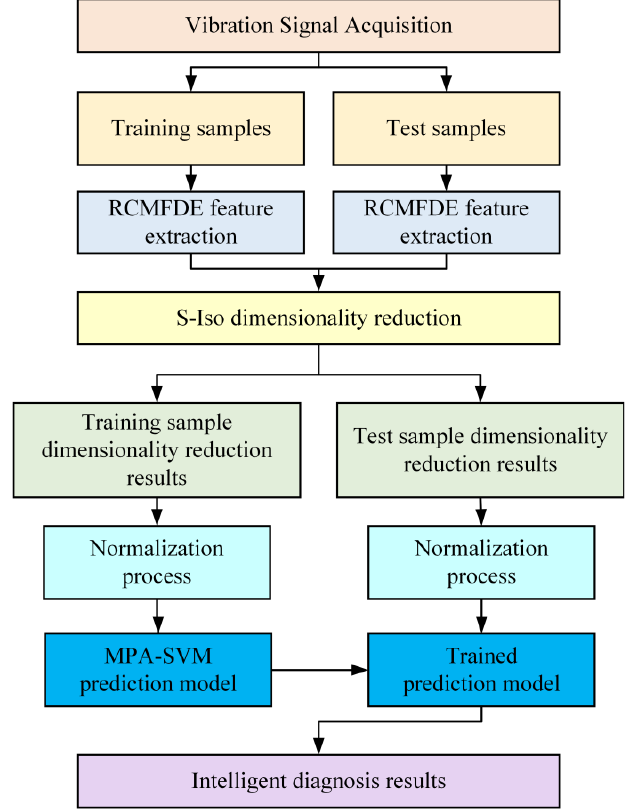
Figure 8. Fault diagnosis scheme for planetary gearboxes.